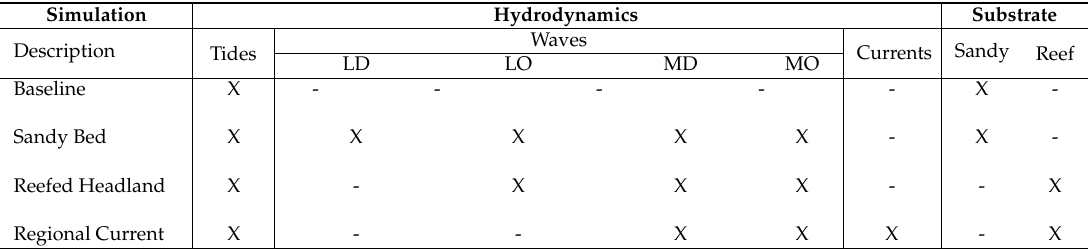
Table 2. Numerical model simulations for each headland type and grain size. Simulation